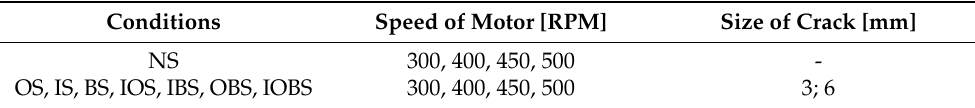
Table 2. Signal information for eight conditions.